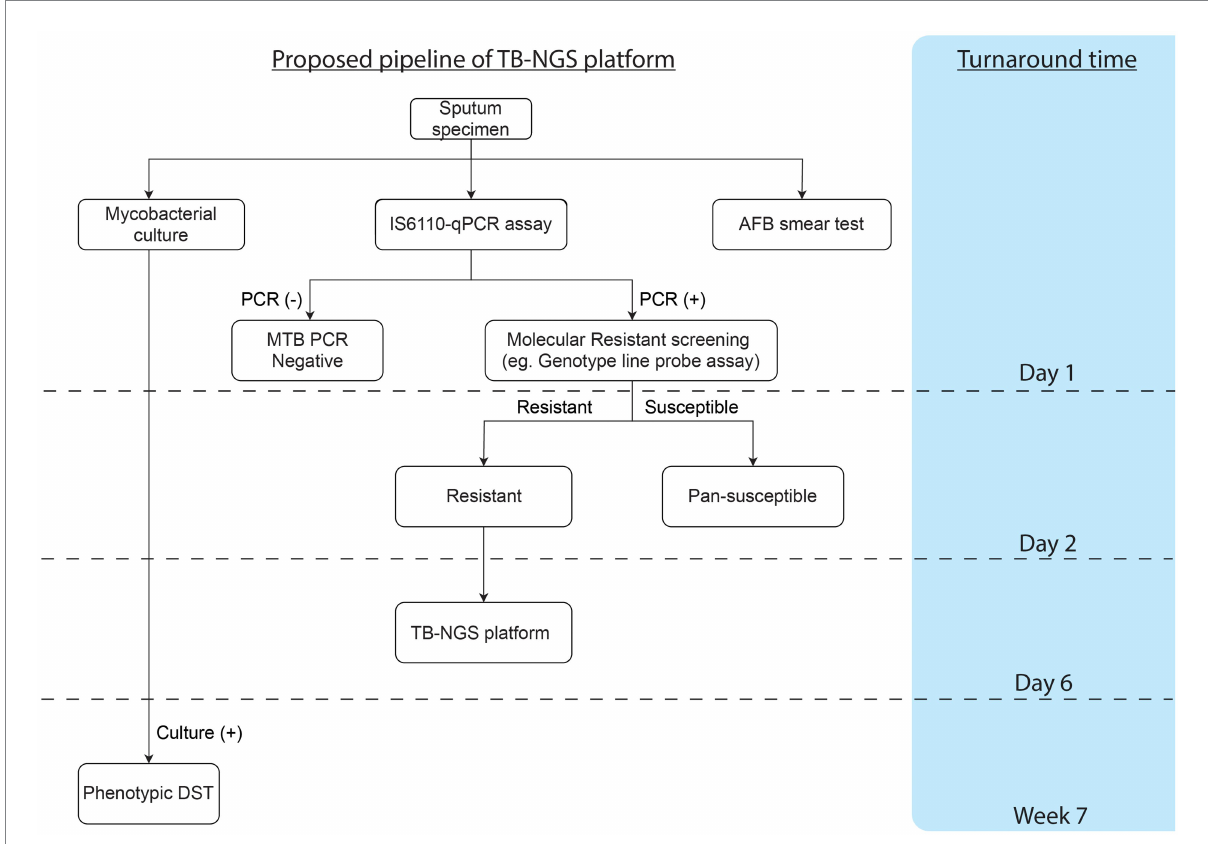
FIGURE 1 Proposed workflow and cumulative turnaround time for each procedure estimated from specimen